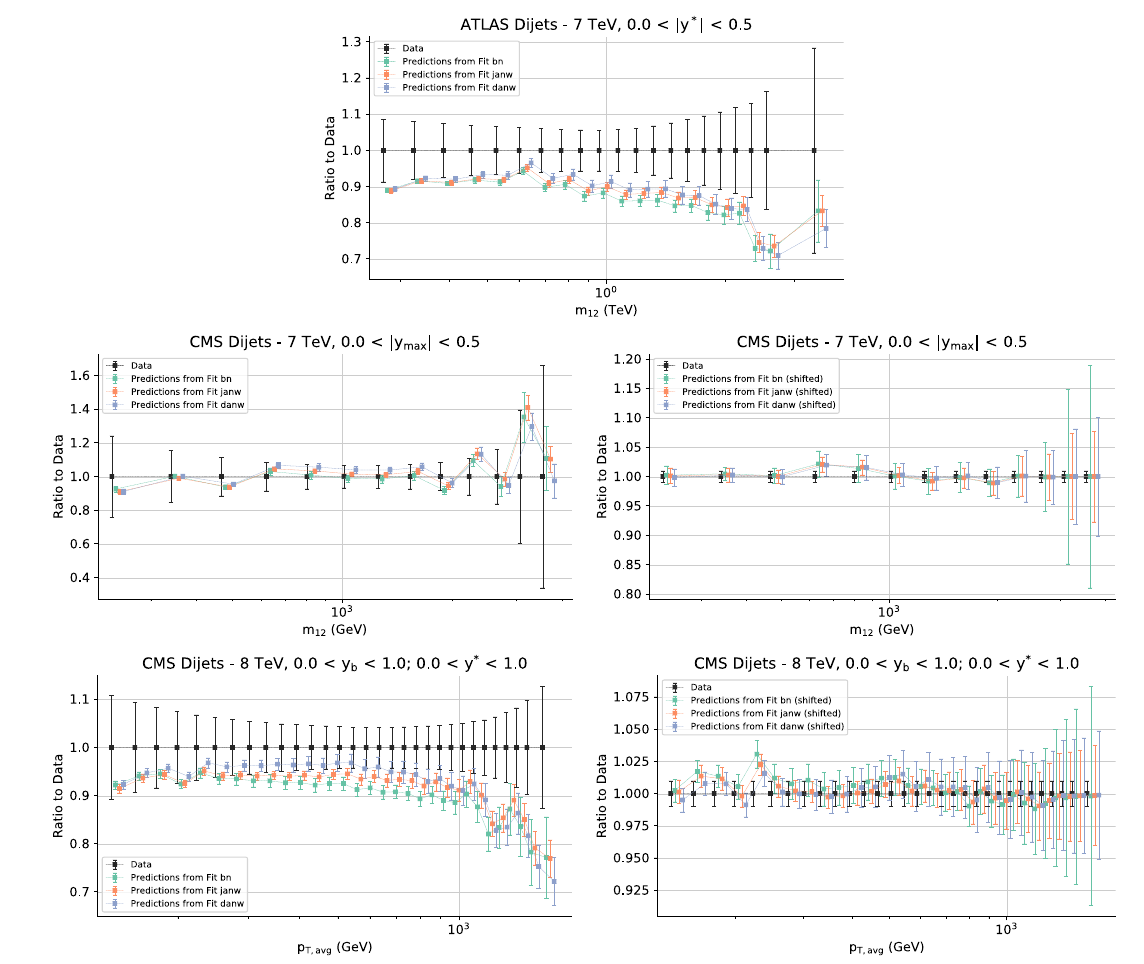
Fig. 19 Same as Fig. 18, but for dijets. For the ATLAS data only the unshifted data are shown because the breakdown of the statistical covariance matrix into fully uncorrelated components is not available